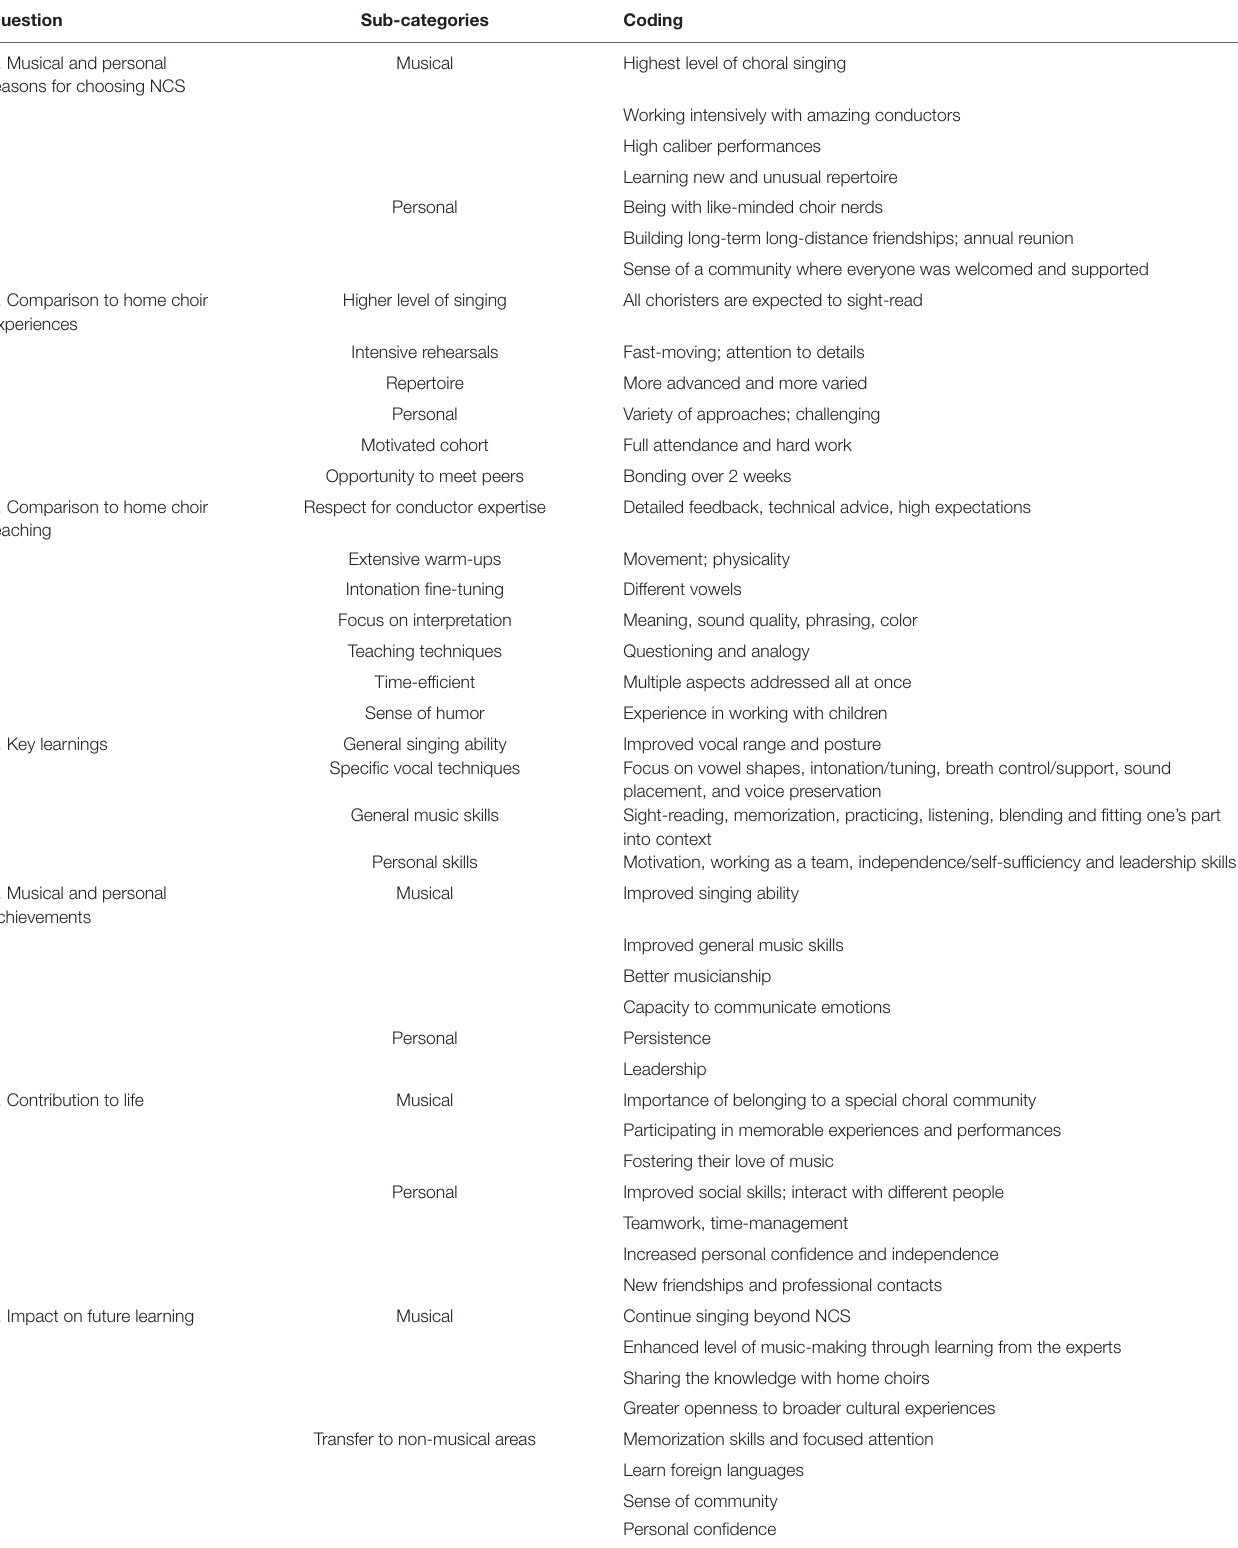
TABLE 2 | Initial coding of factors impacting chorister development in